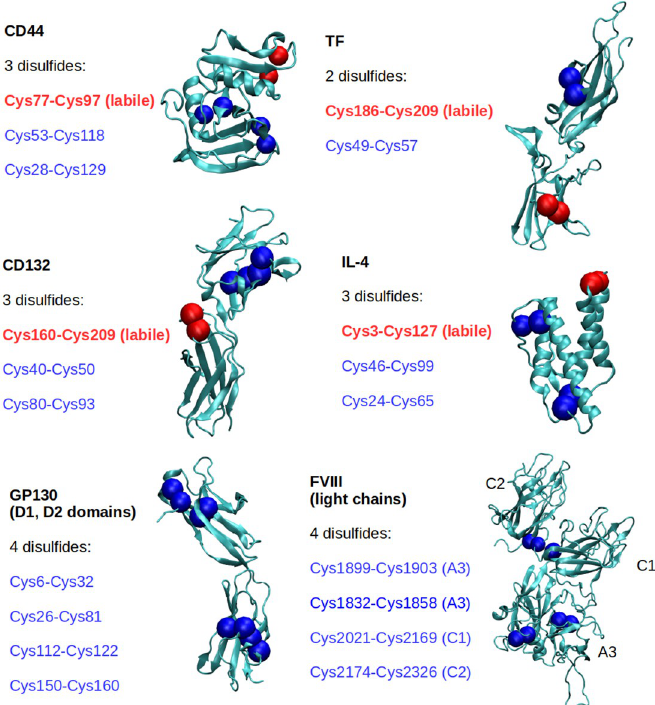
Fig 1. Cartoon representation of the model proteins used for the molecular dynamics (MD) study. The disulfide bonded cysteine residues are highlighted as coloured beads and listed on the left of each snapshot.